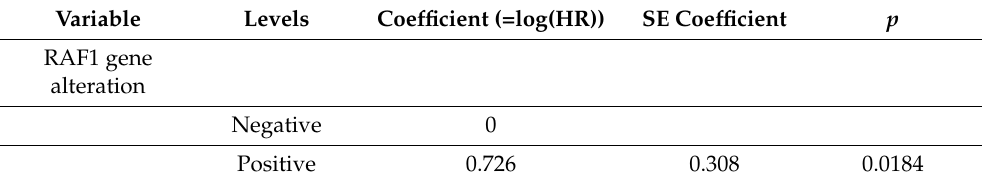
Table 7. Cont. Variable Levels Coefficient (=log(HR)) SE Coefficient p RAF1 gene alteration Negative 0 Positive 0.726 0.308